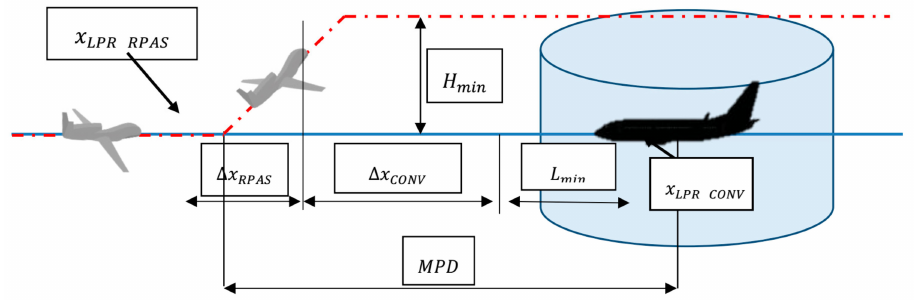
Figure 2. Schematic diagram of the conflict-resolution algorithm in en-route